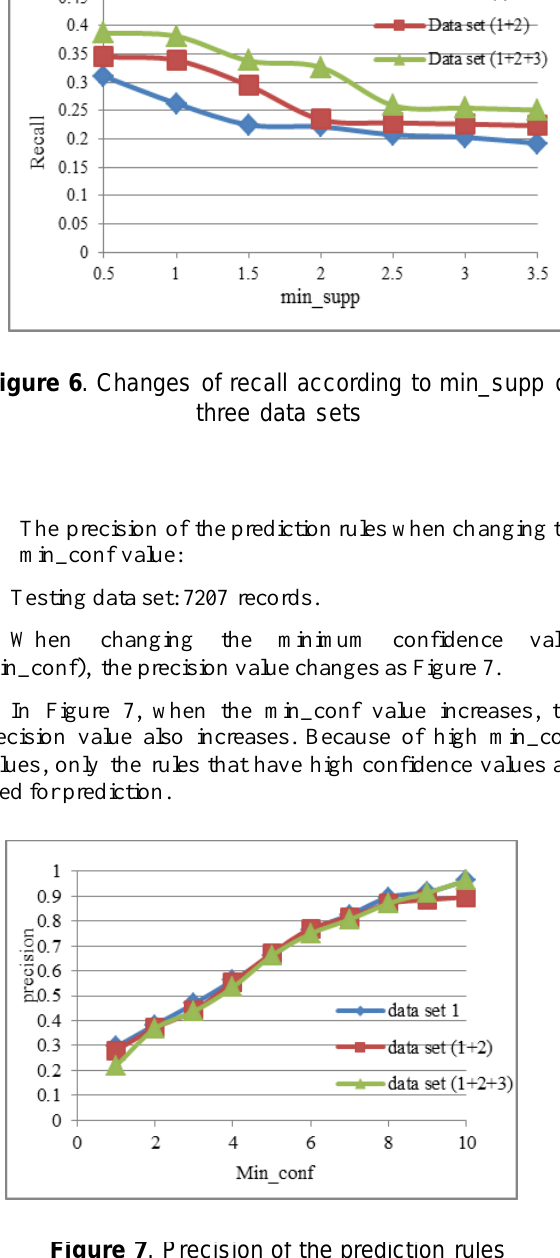
Figure 7 . Precision of the prediction